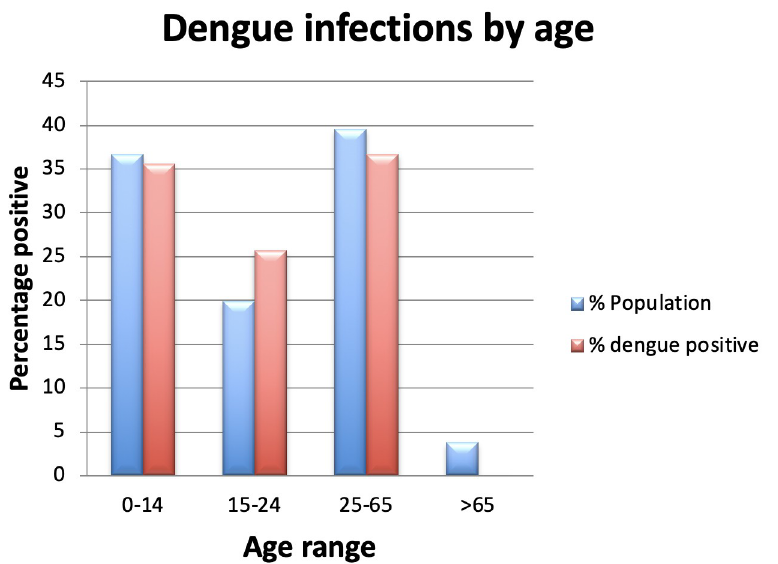
Fig 6. Age distribution of positive